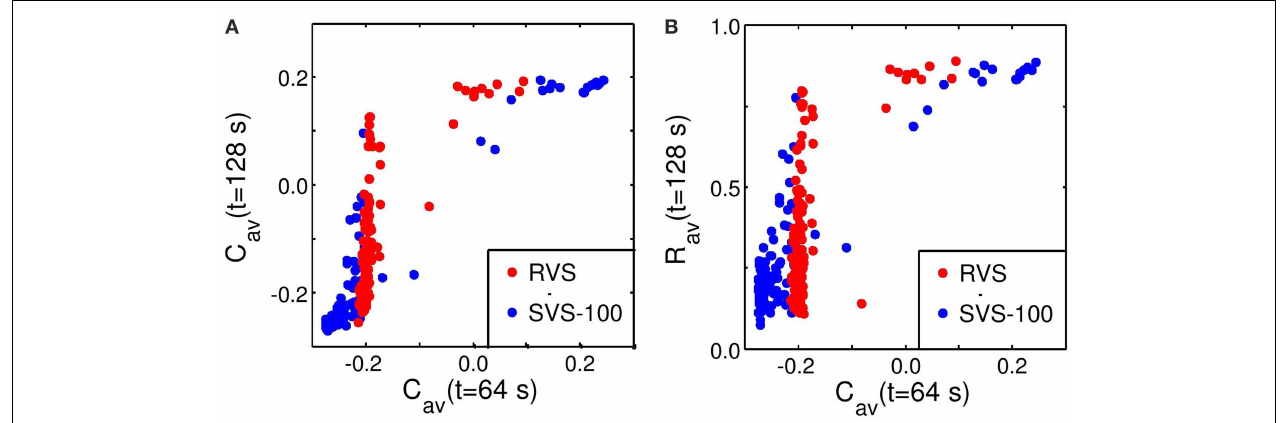
calculated and plotted against C av or R av at t = 128 s for each condition (initial network conditions, stimulation intensity, sequence order, c max = 1 ) as used for Figure 4 . Red circles represent the results of the RVS CR stimulation, blue circles of the SVS-100 CR stimulation. Note that the red circles are plotted on top of the blue